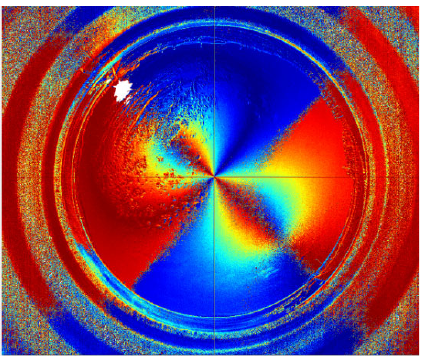
Figure 13. The redrawing result of the AoP distribution according to the new coordinate